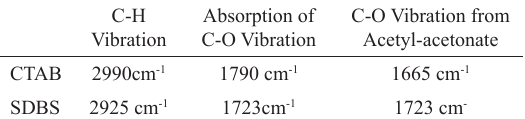
O samples capped with CTAB and SDBS 2 3